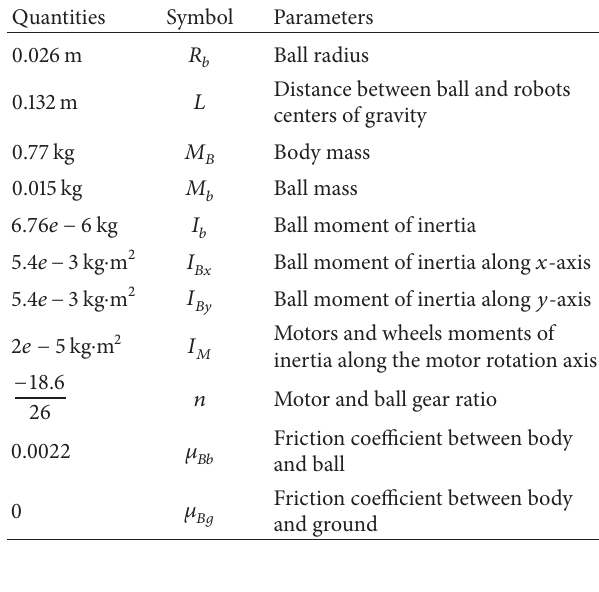
Table 3: Fuzzy rules for sliding mode controller. Table 4: Parameters used in this